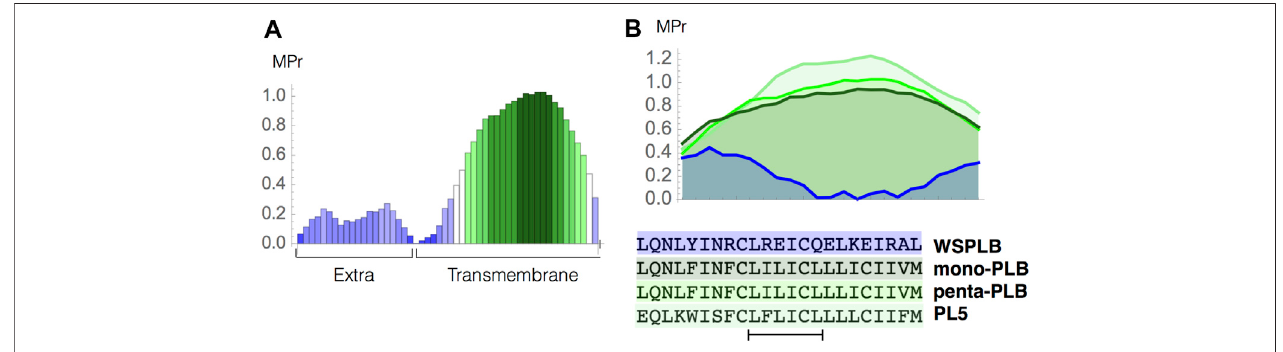
FIGURE 5| Phospholamban case study. (A) MPr values computed for the pentameric structure ofthe full-length phospholambam (PDB code 1zll); (B) amino acid sequencesandMPrvaluesfortheTMfragment(residues28 – 50)offourdifferentPLBstructures:PLBmonomer(lightgreen,PDBcode1zll),PLBpentamer(green,PDB code 1zll), redesigned pentamer PL5 (dark green, PDB code 6mqu) and water soluble PLB tetramer (blue, PDB code